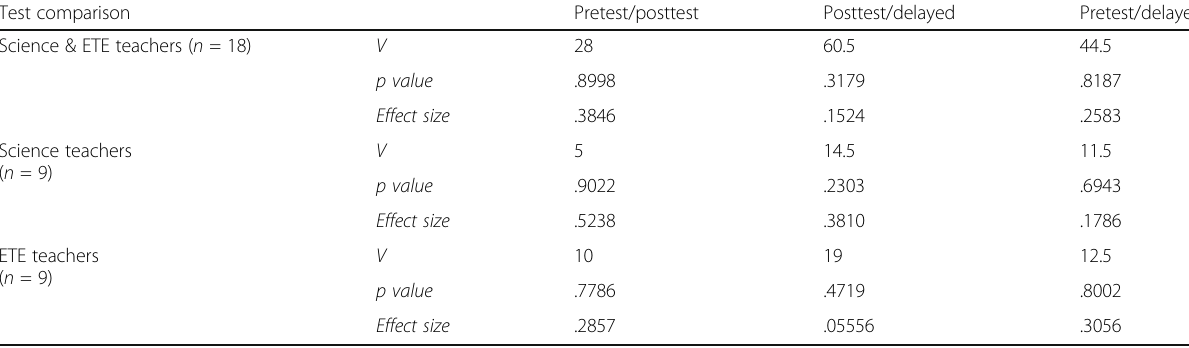
Table 7 Summary of statistical tests for significant differences for the control group (V, p value and effect size) Test